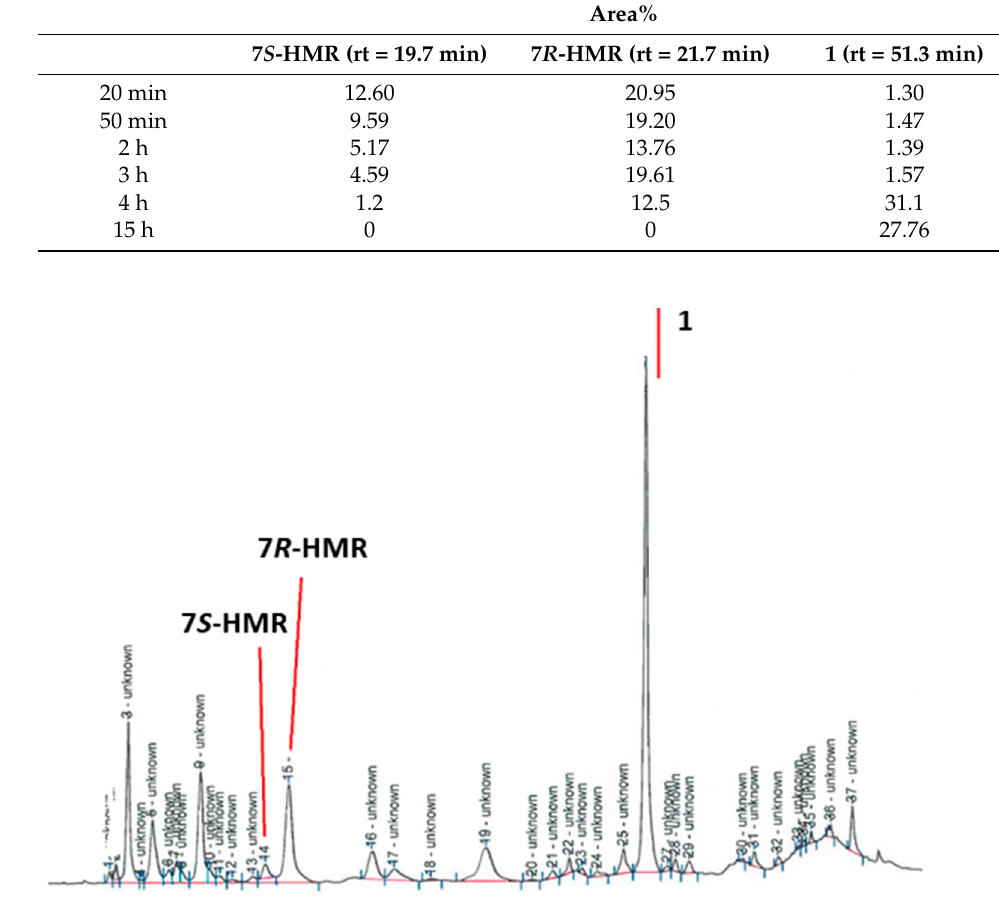
Table 1. HPLC monitoring of the reduction reaction after 15 h.